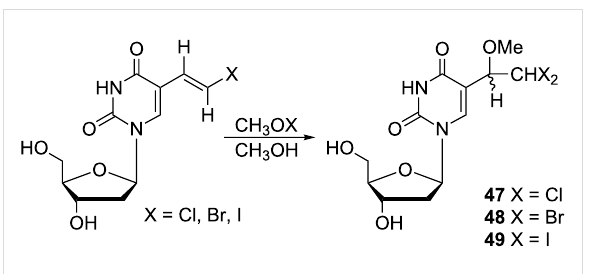
Scheme 7: 5-(1-Methoxy-2,2-dihaloethyl)-2'-deoxyuridines 47 – 49 .